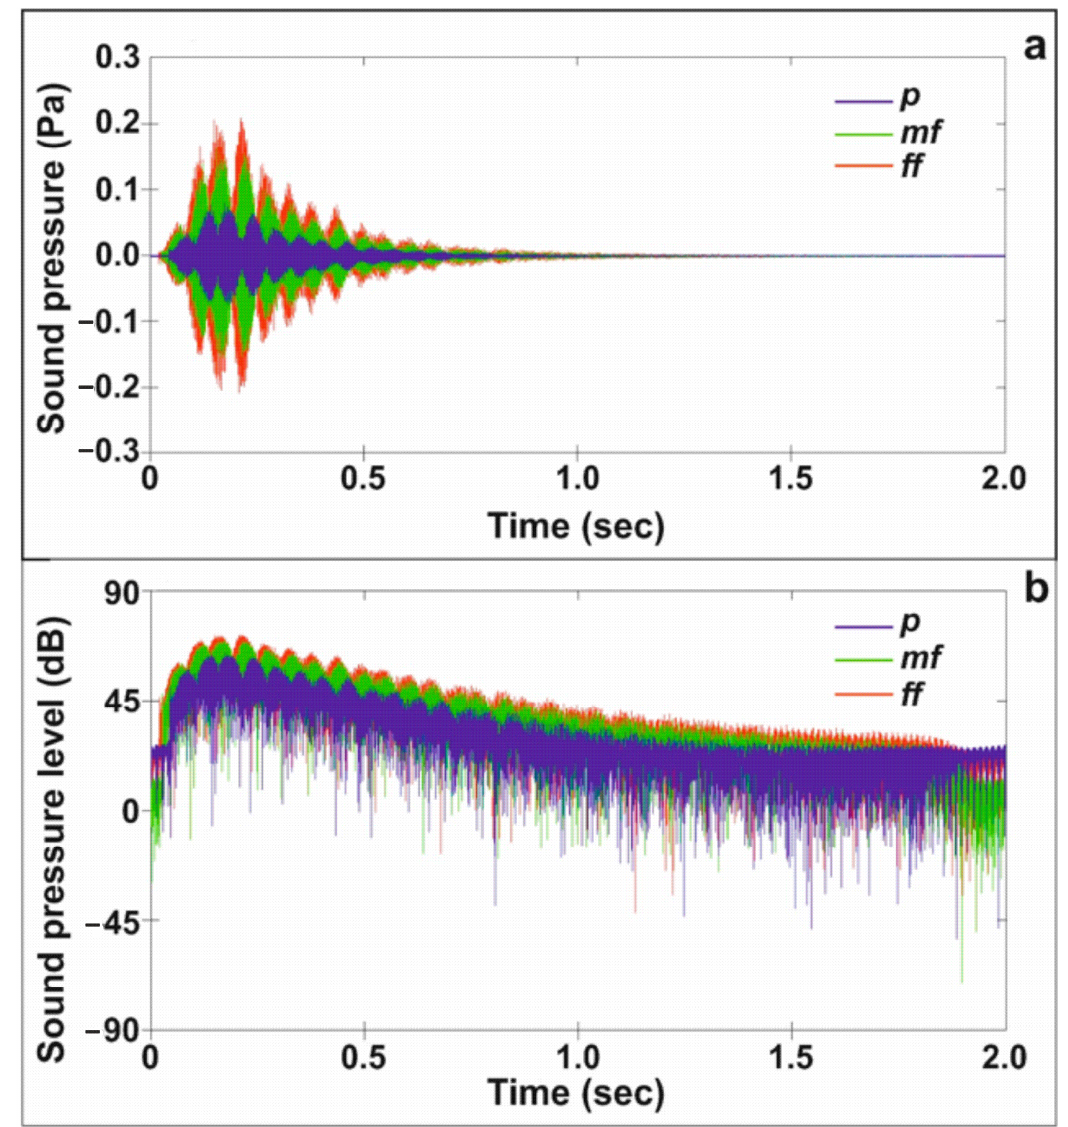
Figure 5. Computed ( a ) sound pressure and ( b ) SPL values of the emitted sound for the three progressively intensified free strokes p , mf , ff.